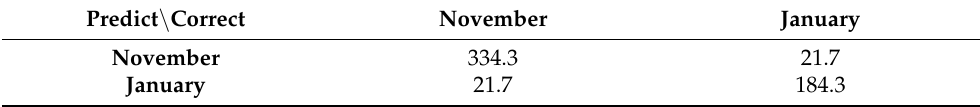
Table 1. Confusion matrix of the constructed SVM model for harvest period classification.